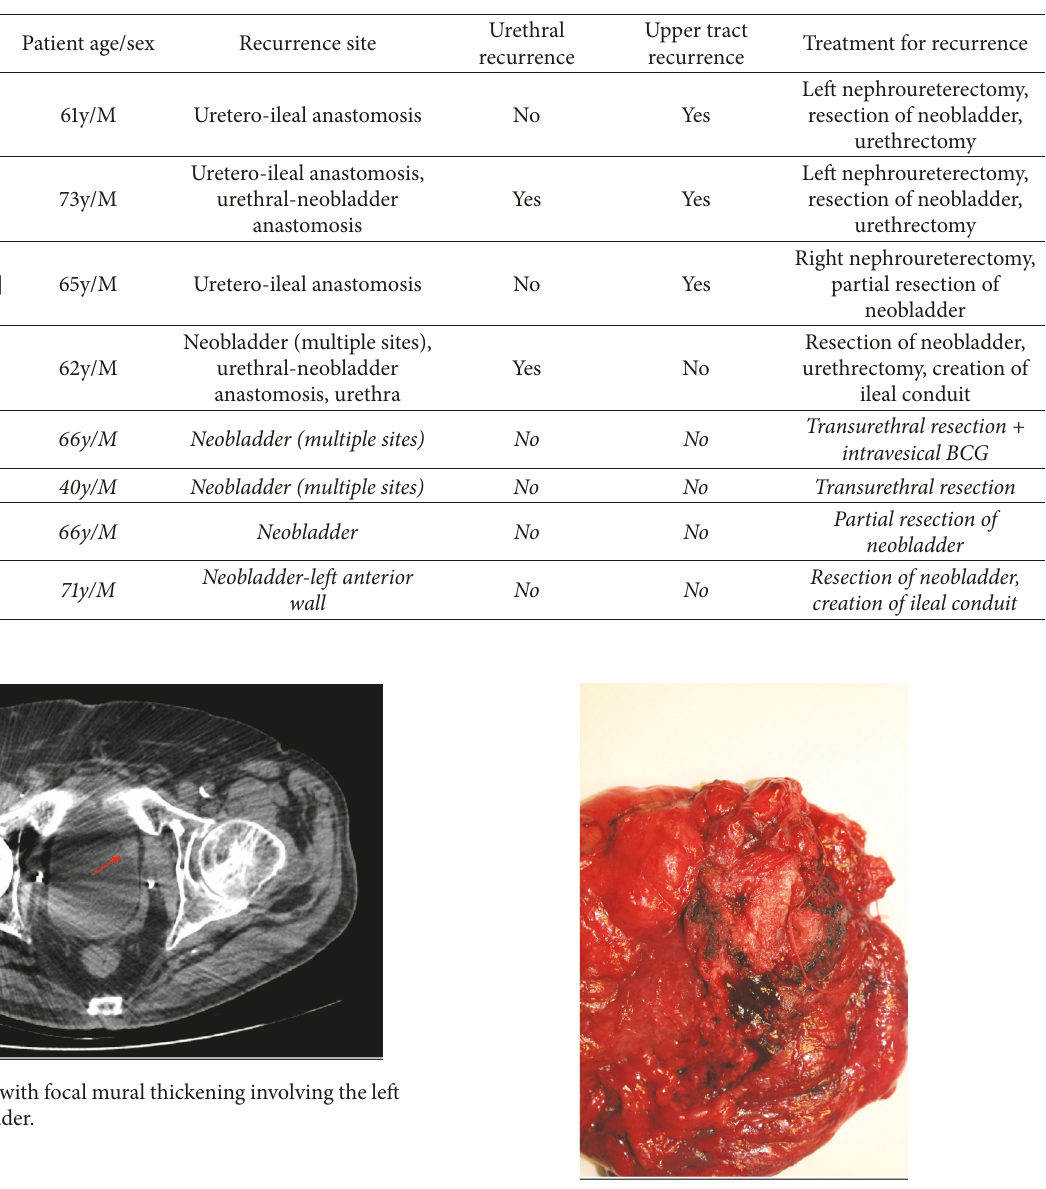
Table 1: Cases of urothelial cell carcinoma recurrence in ileal neobladder.